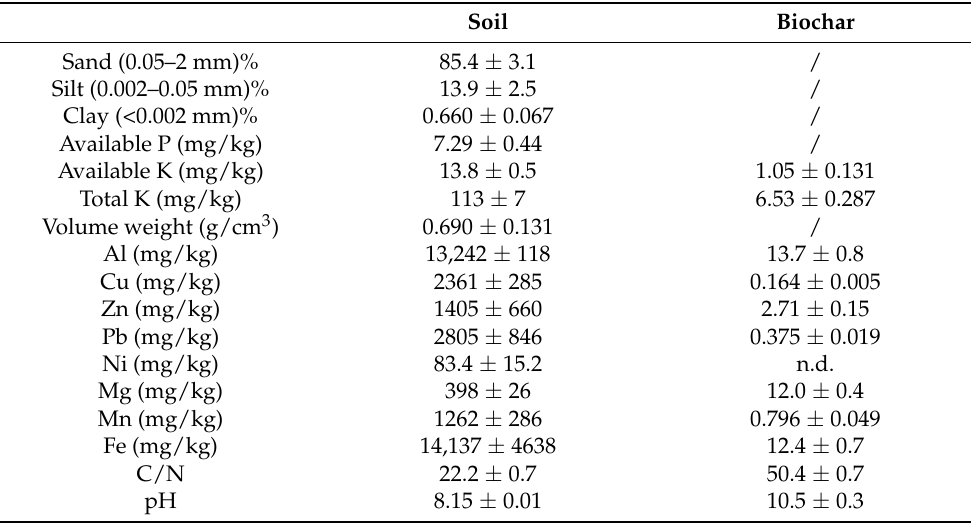
Table 1. Basic physical and chemical properties of soil and